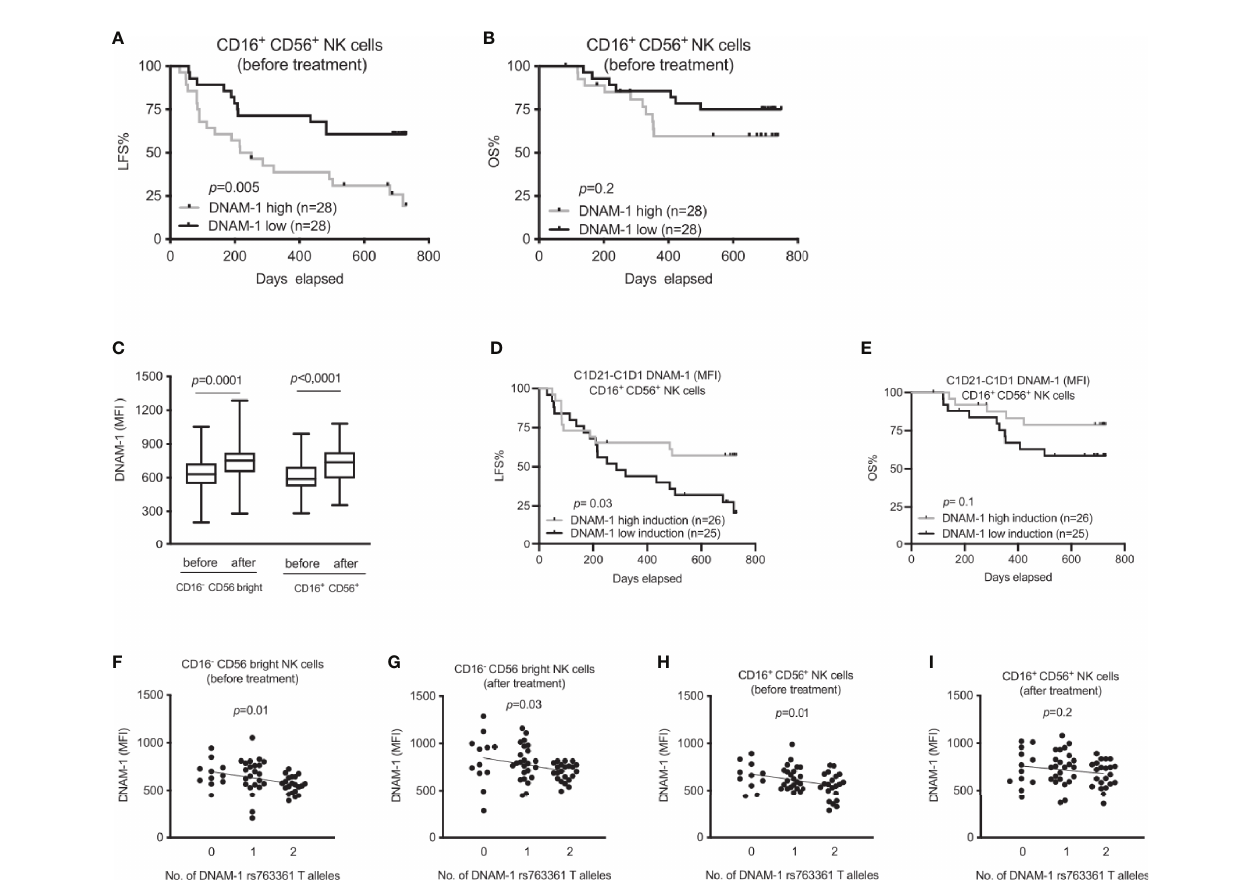
FIGURE 2 | Association between DNAM-1 expression and outcome of immunotherapy in AML. (A, B) Leukemia-free survival (LFS) and overall survival (OS) of AML patients before immunotherapy according to DNAM-1 expression (MFI) in speci fi ed NK cell subsets. (C) Box plot shows effect of HDC/IL-2 therapy on median fl uorescence intensity (MFI) of DNAM-1 expression in both CD16 - CD56 bright and CD16 + CD56 + NK cells of AML patients both at the beginning (n=51) and after (n=59) of treatment. (D, E) Impact of induction of the CD16 + CD56 + NK DNAM-1 expression on LFS and OS during fi rst three weeks of immunotherapy in AML. Patients were dichotomized based on above (grey) and below (black) median expression (MFI) of DNAM-1. (F – I) Expression of DNAM-1 in AML patients during immunotherapy based on number of DNAM-1 rs763361 T alleles in CD16 - CD56 bright and CD16 + CD56 + NK cells before and after receiving one cycle of HDC/IL-2 therapy. Patients are divided according to indicated number of T alleles [n equals 11, 23 and 21 before immunotherapy; panels (F, H) ; and 12, 24 and 22 after one cycle of immunotherapy; panels (G, I) ]. Paired two-sided t test was performed to analyze the difference in DNAM-1 expression before and after therapy in different NK cell subsets in fi gure (C) . Logrank test was carried out for survival analysis in fi gures (A, B, D, E) . Simple linear regression was implemented to investigate impact of DNAM-1 rs763361 gene variants on expression of DNAM-1 both before and after immunotherapy in various NK subsets as shown in fi gures (F – I)